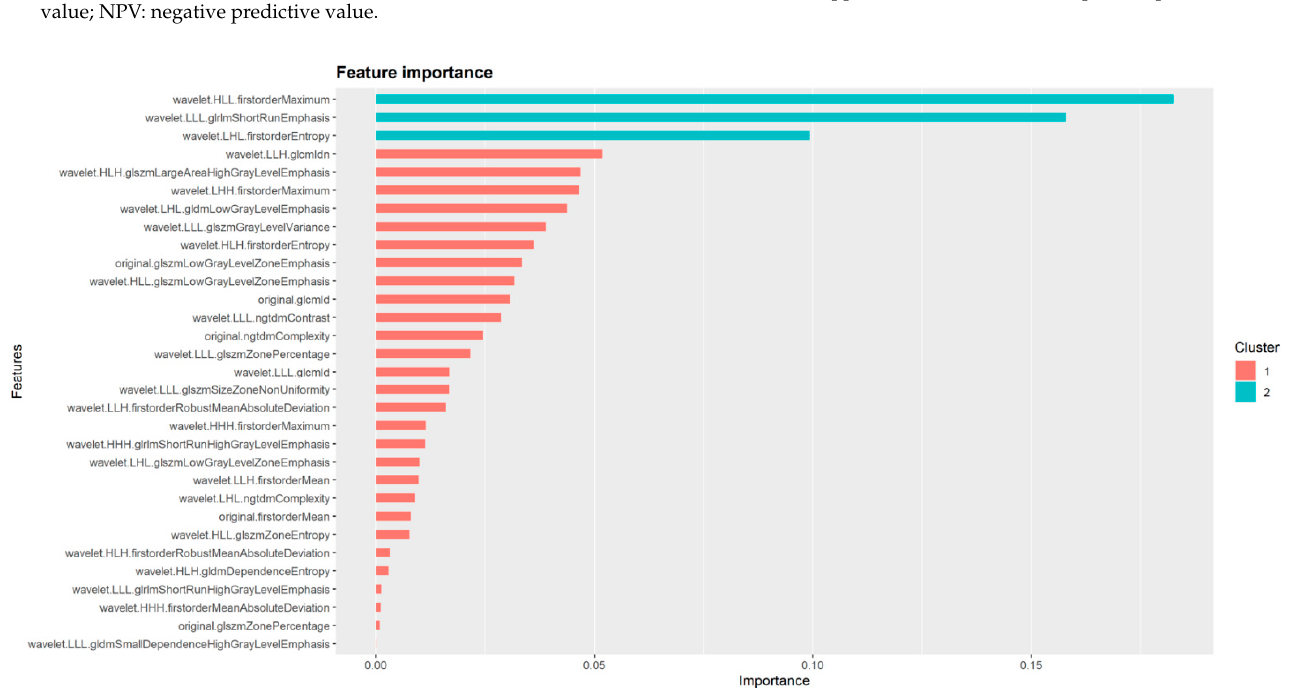
Figure 5. Radiomics features identified as important for the performance of XGboost. Important features belong to two clusters based on their degree of importance. Cluster 2 contains three features which represent the most important determinants of XGboost performance in differentiating between TOH and AVN. Table 2. Performance of the three machine learning algorithms.